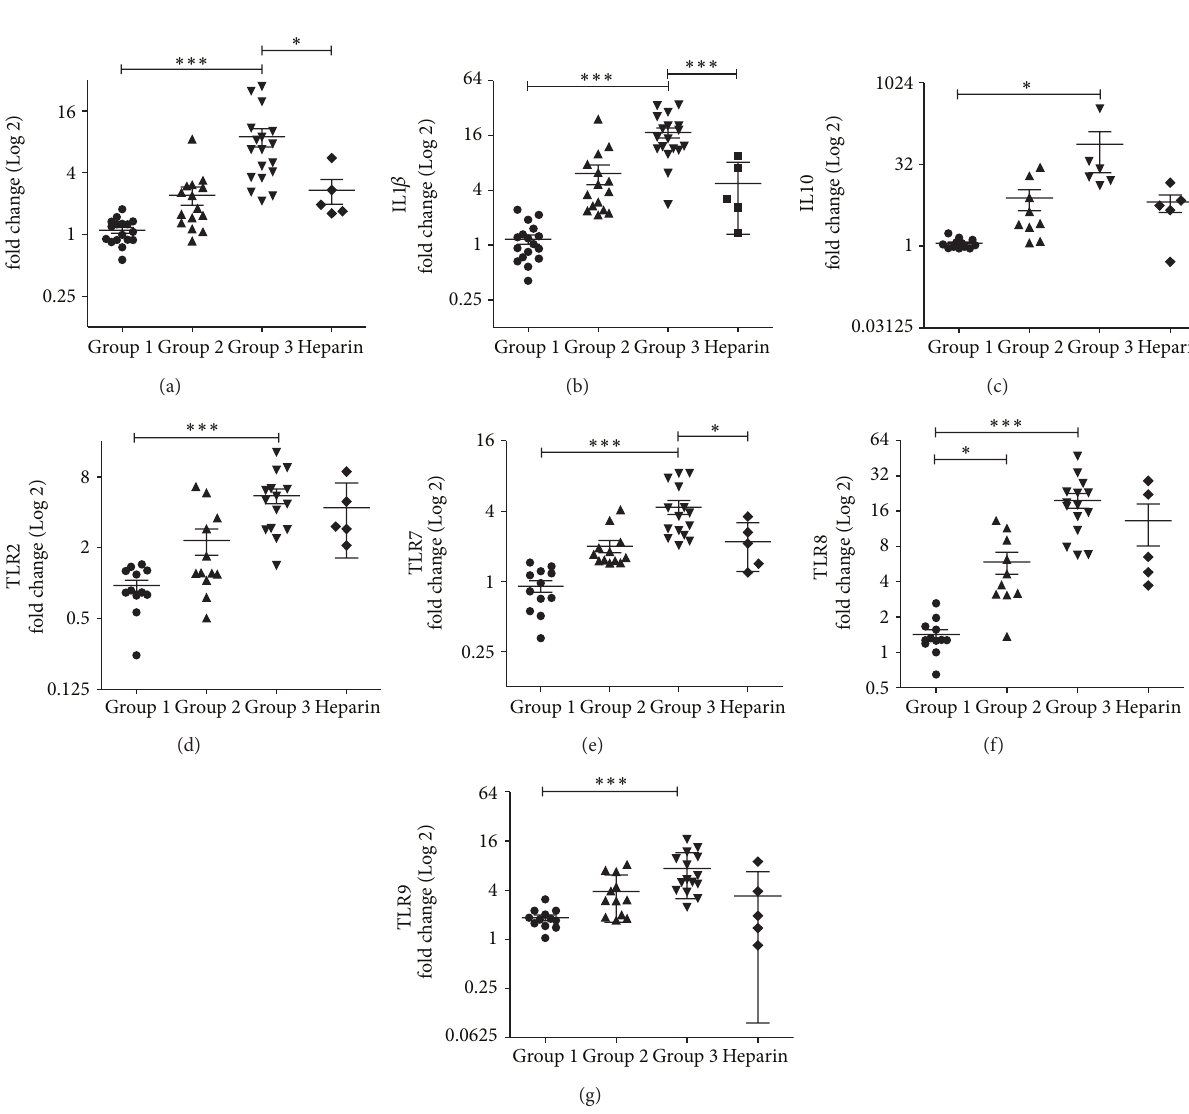
Figure 2: Heparin treatment affects the mRNA expression of CCR2, IL1 𝛽 , and TLR7 in kidneys of B/W mice. The mRNA expression of CCR2 (a), IL1 𝛽 (b), IL10 (c), TLR2 (d), and TLR7 (e) was increased in Group 3 mice compared to Group 1 mice. The mRNA expression of CCR2 (a), IL1 𝛽 (b), and TLR7 (e) was significantly reduced in Heparin-treated mice compared to Group 3 mice. Data is given as Log2 of mean ± SEM of fold change values normalized against 4-week-old mice ( 𝑛 = 3 ). 𝑃 values are calculated using one-way ANOVA followed by Bonferroni posttest. ∗ 𝑃 < 0.05 ; ∗∗ 𝑃 < 0.01 ; ∗∗∗ 𝑃 < 0.001